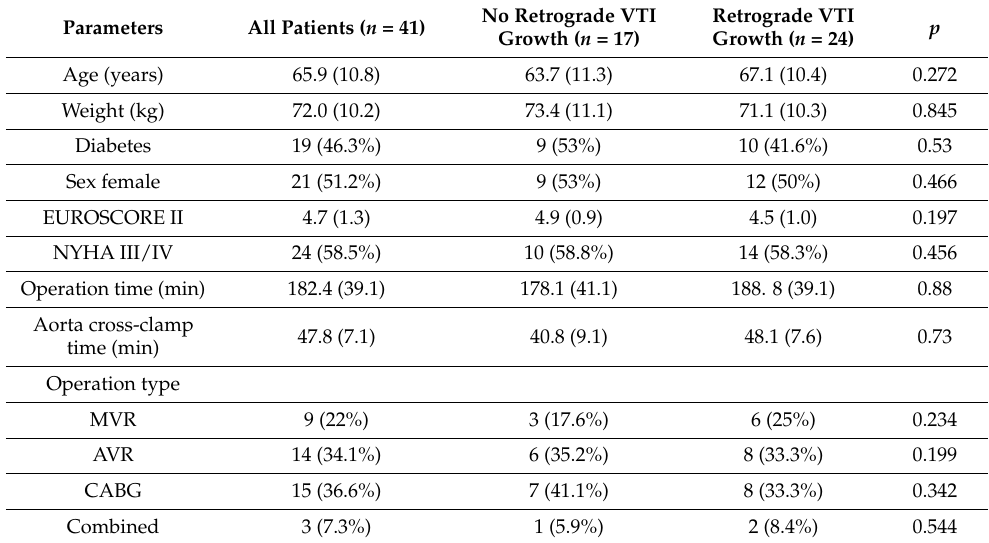
Table 1. Demographic and clinical parameters (operation time and risk factors).